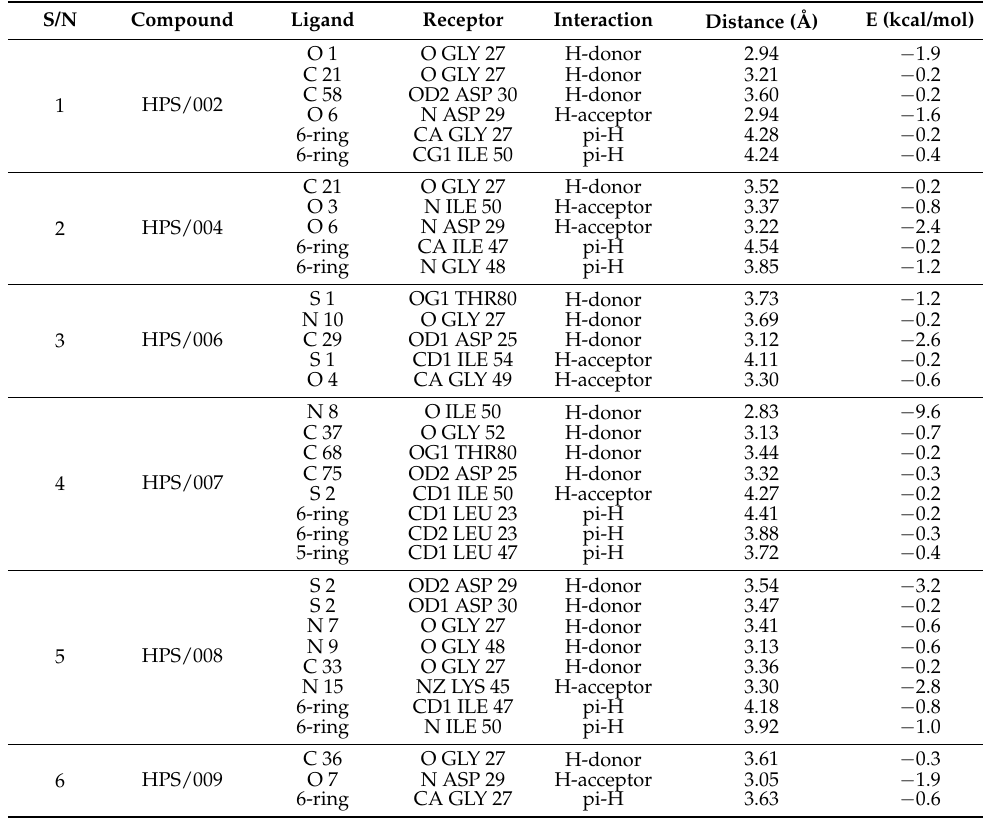
Table 3. Binding interactions of the hit compounds with 2Q5K.